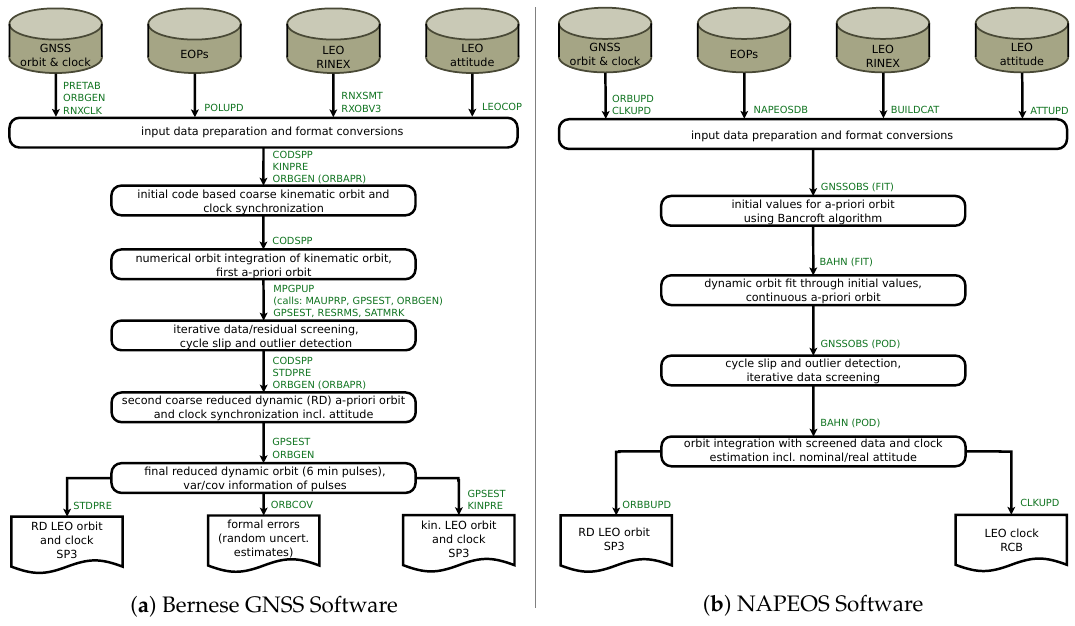
Figure A1. Schematic illustration of the orbit processing setup of the Bernese and NAPEOS software packages used in this study for the LEO POD. The main processing steps from input data (top) to POD results (bottom) are shown and software-internal routines used for specific steps are indicated by their names (green names near arrows; for details see the software documentation [30,31]). For explanation of acronyms in various boxes see the Abbreviations list